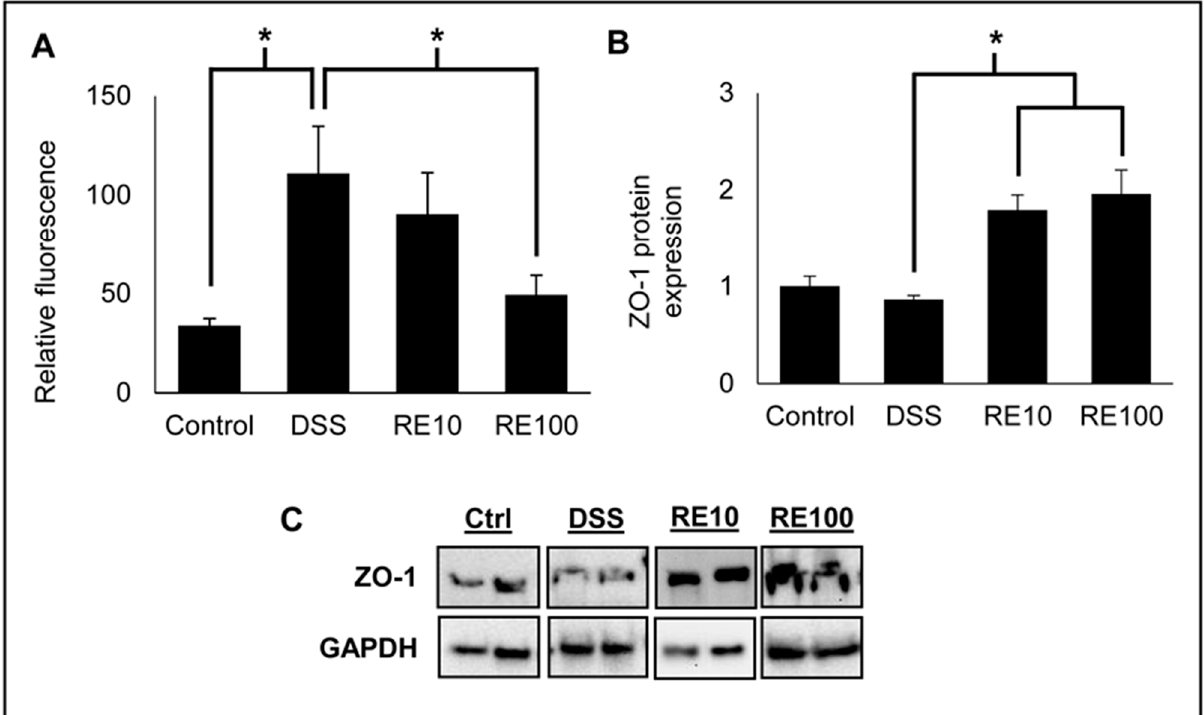
Figure 7. Rosemary extract (RE) protected against loss of barrier integrity in DSS-induced colitis mice. FITC–dextran was administered and analyzed in mouse plasma according to Section 2.12 ( n = 7 samples per group). ( A ) DSS administration significantly increased plasma levels of FITC, indicating severe loss of intestinal barrier integrity. RE at 100 mg/kg protected intestinal barrier disruption as shown by decreased plasma FITC compared to negative control. ( B ) Zonula occludens-1 (ZO-1) protein expression from mouse colon lysates was analyzed by Western blot. RE administration at both 10 and 100 mg/kg significantly increased ZO-1 protein expression. (C) Western blot images of ZO-1 protein expression in mouse colon lysates representative of each group from the DSS colitis experiment. One-way ANOVA followed by Tukey’s HSD was used to determine significance. * p < 0.05.